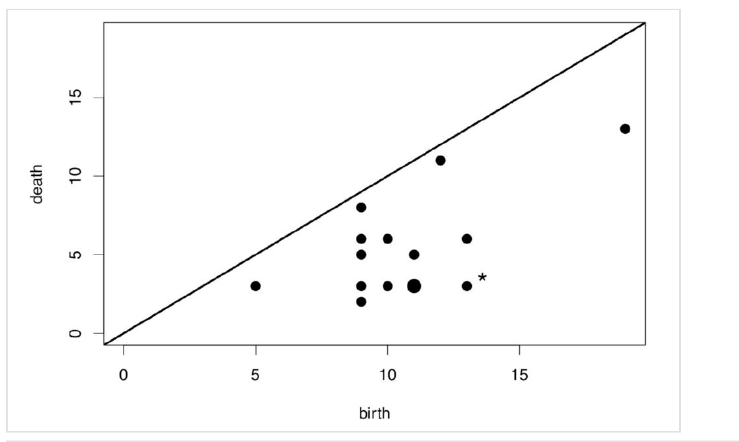
Persistence plot showing third- and higher-order dependence in the fMRI BOLD data from an individual control subject (as in Aim 1). The larger disk indicates two coinciding points. The point with the asterisk is discussed in 3.4.1, Example